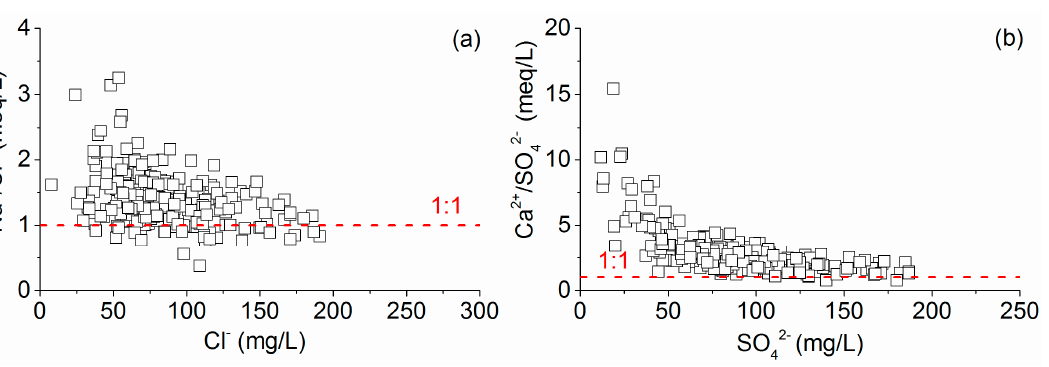
Figure 5. Bivariate diagrams of halite ( a ) and gypsum/anhydrite ( b ) weathering and